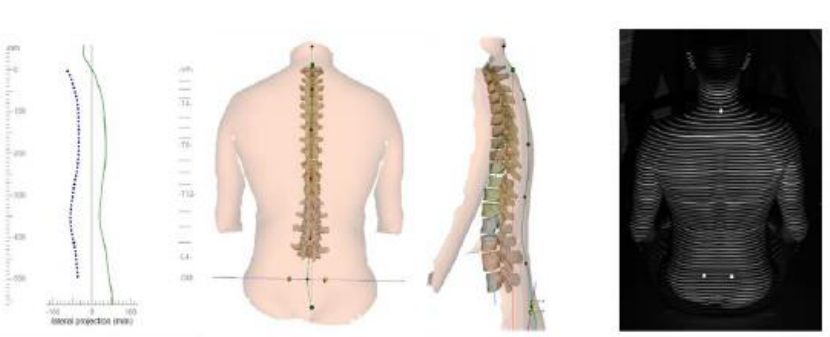
Figure 7. Sitting position on a dynamic chair.